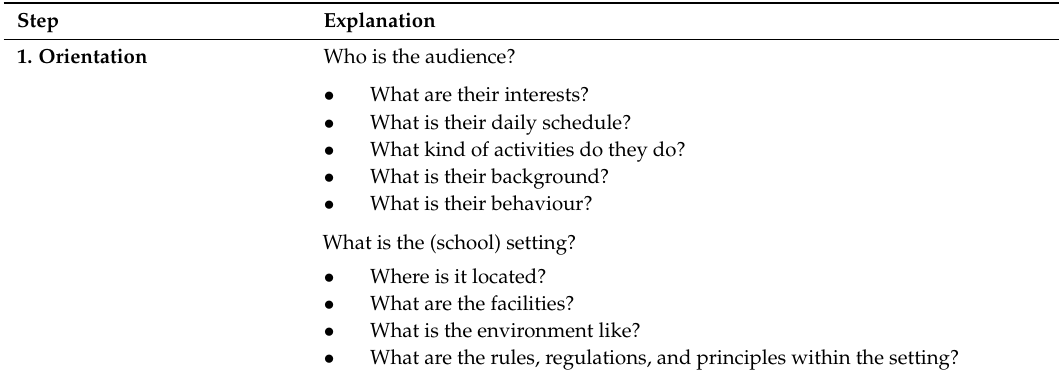
Table 2. Steps for nutrition education targeting youth, adapted from Porter et al. (2018), the U.S. Department of Health (1992) and Salem et al. (2017)